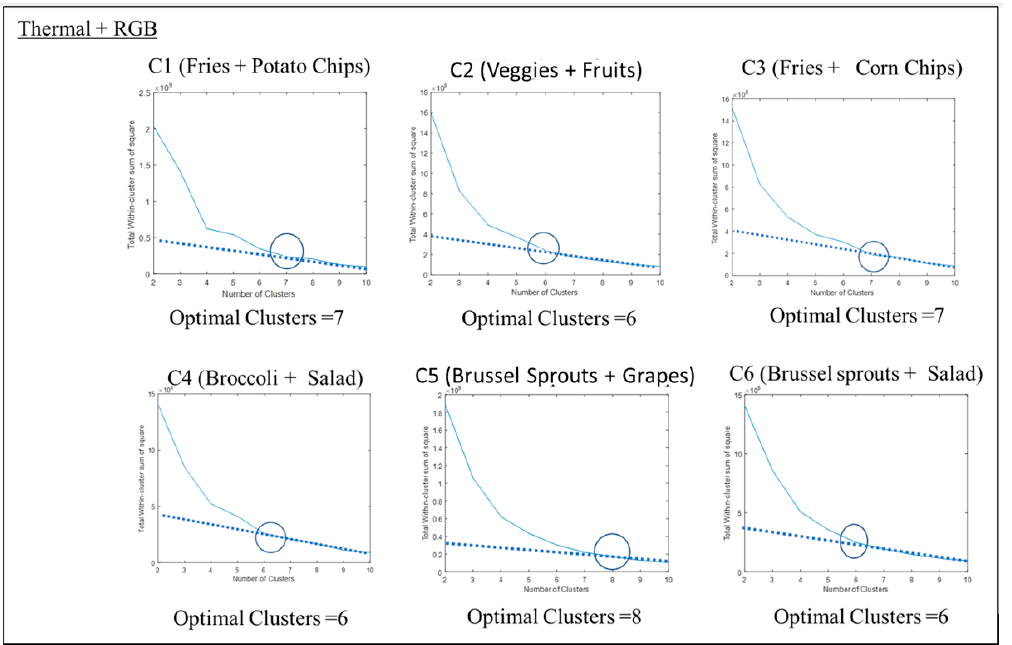
Figure A1. WSS Optimization scheme to determine the number of optimal clusters in RGB-T data.